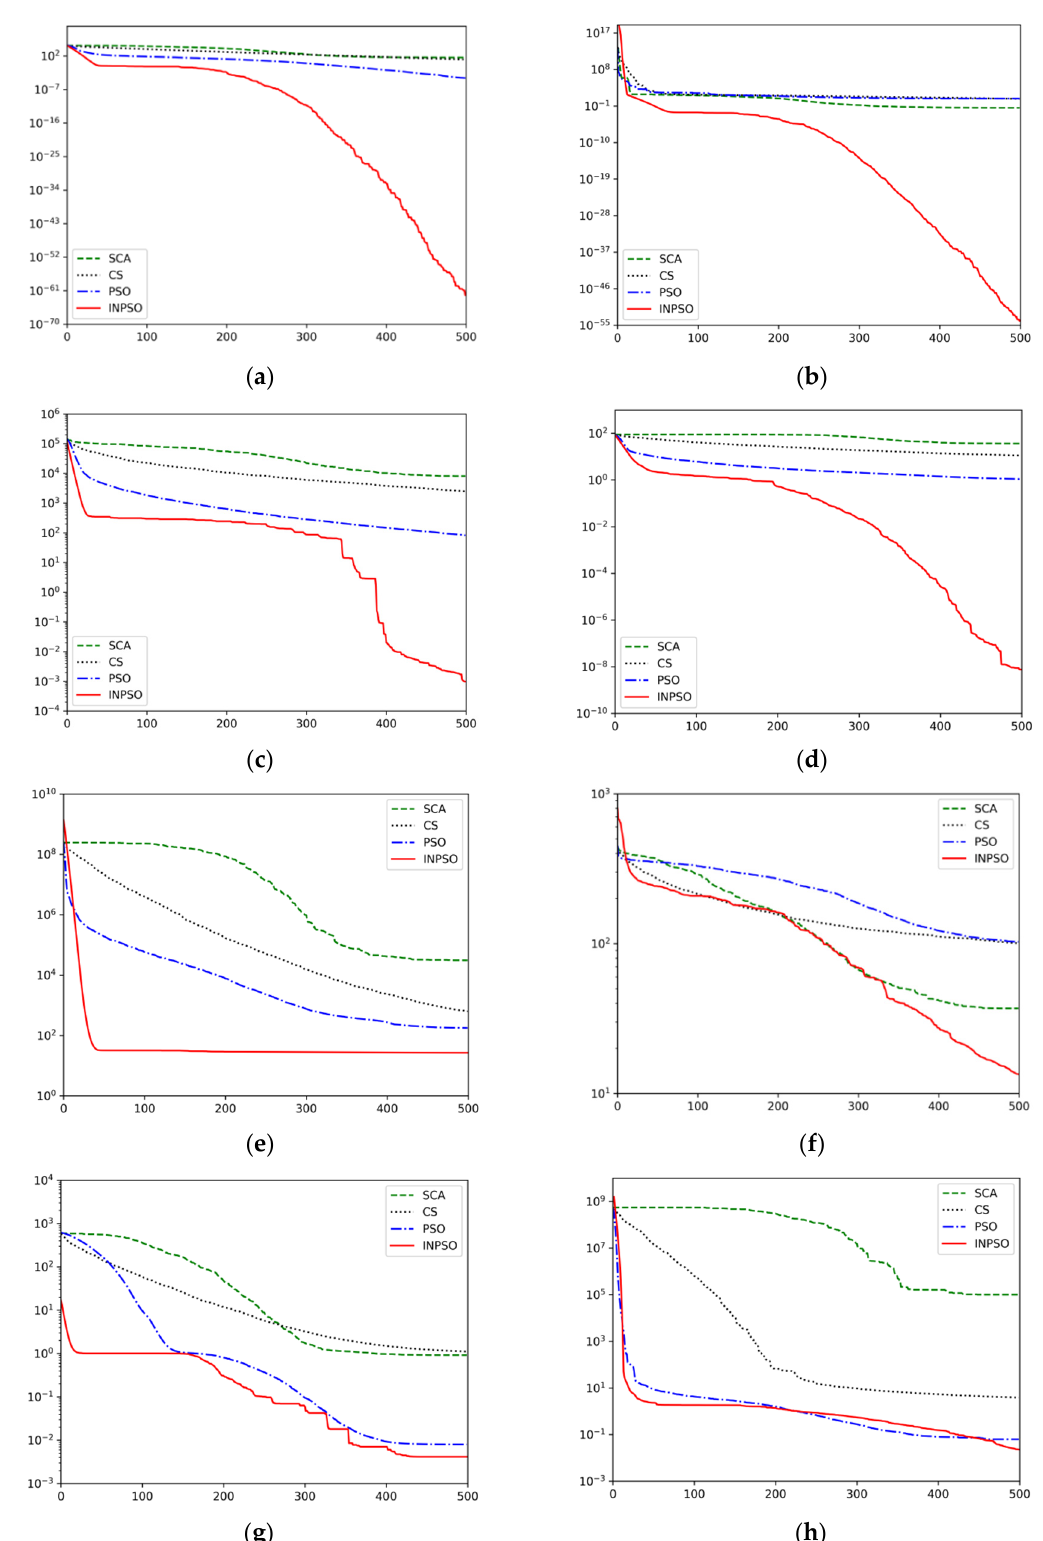
Figure 4. Convergence trends for INPSO versus other optimizers: ( a ) Sphere function, ( b ) Schwefel 2.22 function, ( c ) Schwefel 1.2 function, ( d ) Schwefel 2.21 function, ( e ) Rosenbrock function, ( f ) Rastrigin function, ( g ) Griewank function, ( h ) penalized function.